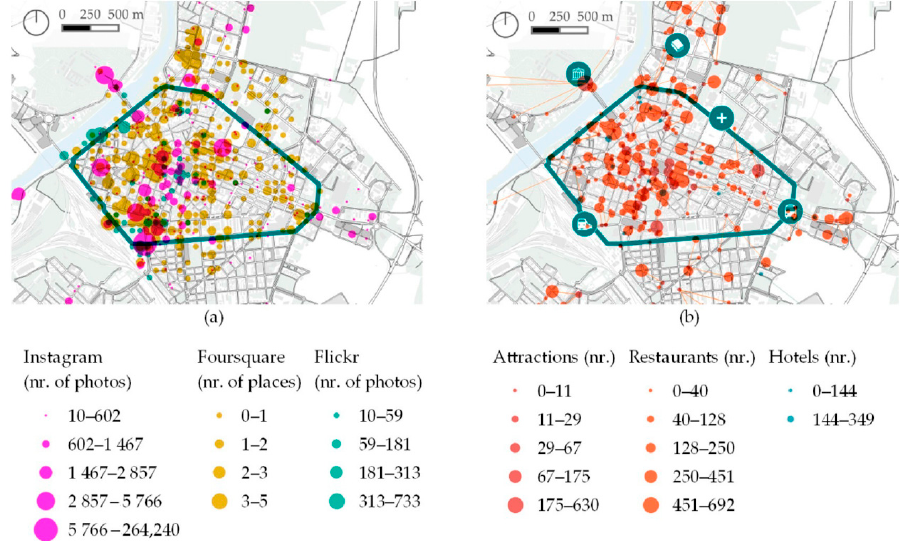
Figure 4. ( a ) The map shows the distribution of social network activity in the historical center of Alessandria: in magenta, the Instagram places, sized by the number of photos, in yellow, the different concentrations of Flickr photos, in green, the different concentrations of Foursquare places; ( b ) the map shows the distribution of digital activity related to touristic attraction; in particular, in orange, the restaurants, sized by the number of Tripadvisor reviews, in red the attractions, sized by the number of reviews, in green, the hotels, sized by the number of reviews, whereas the lines link the restaurants/hotels to the closest attraction [Sources: Authors, OpenStreetMap, Municipality of